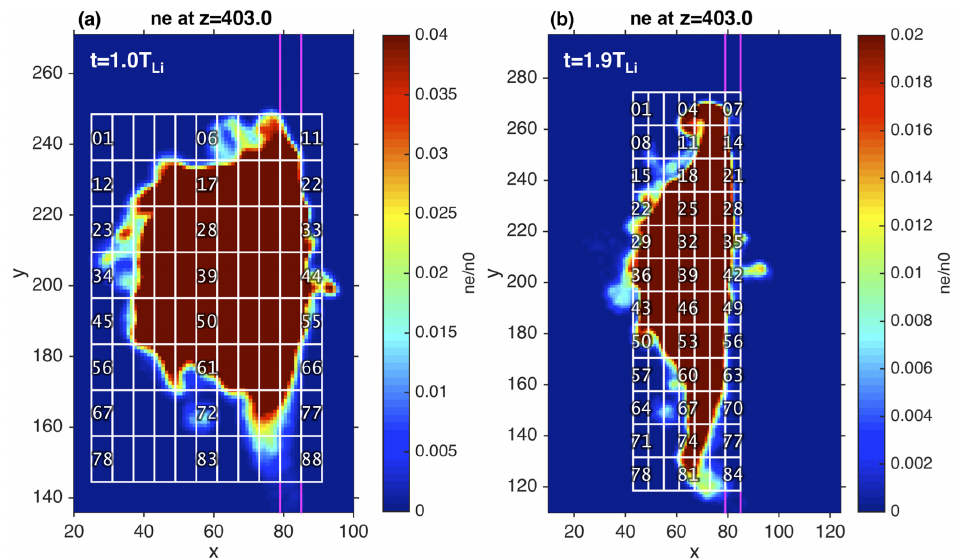
Figure A1. Electron number density for the z = 403 cross section together with the entire spatial grid used to calculate the electron velocity distribution functions, at (a) t = 1 T Li and (b) t = 1 . 9 T Li . There are 88 spatial bins in panel (a) and 84 in (b)